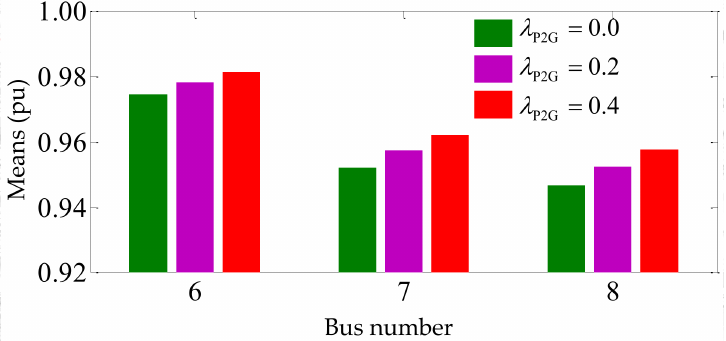
Figure 11. Mean values of voltage magnitudes of buses 6, 7 and